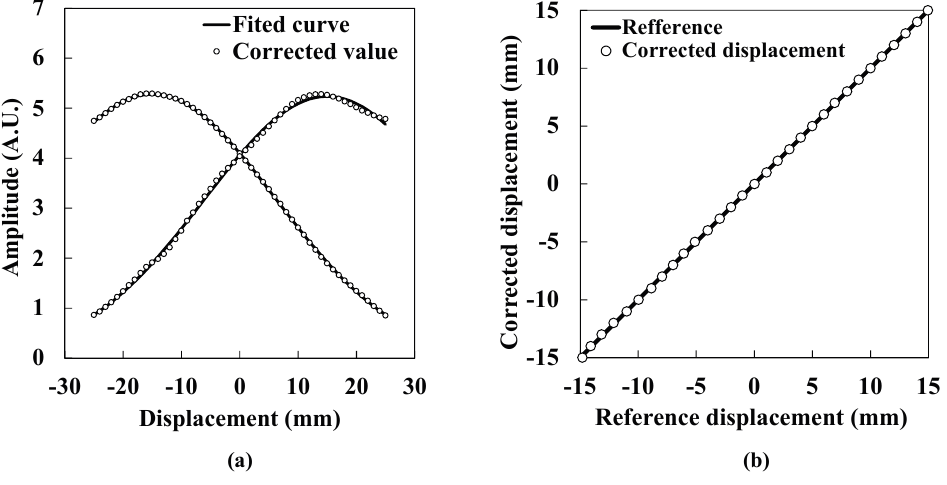
Figure 9. ( a ) Corrected ultrasound intensity distribution; ( b ) Corrected lateral displacement.